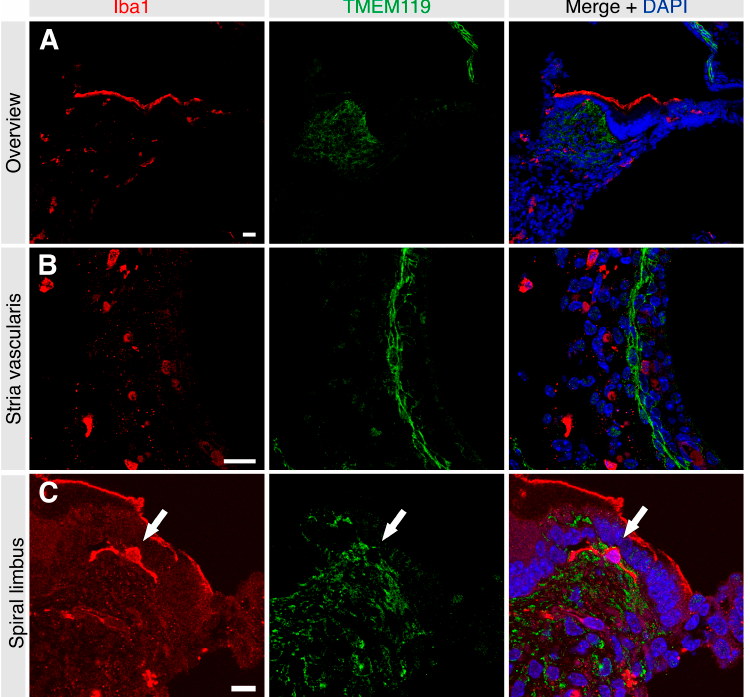
Figure 2. Frozen sections of the immature mouse cochlea at p3 were labeled for both Iba1 (red) and TMEM119 (green). Nuclei were counterstained with DAPI (blue). ( A ) TMEM119 was detected in the spiral limbus and cochlear lateral wall. Iba1-positive cells were detected in the stria vascularis and among spiral ligament fibrocytes, showing no obvious pattern of overlap with TMEM119-positive cells. Scale bar: 20 µ m. ( B ) TMEM119 signal (green) was detected in the intermediate and basal cell layers of the stria vascularis, showing no overlap with Iba1-positive cells of the lateral cochlear wall. Scale bar: 20 µ m. ( C ) TMEM119 protein expression was detected among most fibrocytes of the spiral limbus at p3. Some scattered double-positive cells were detected in the spiral limbus (arrow). Scale bar: 10 µ